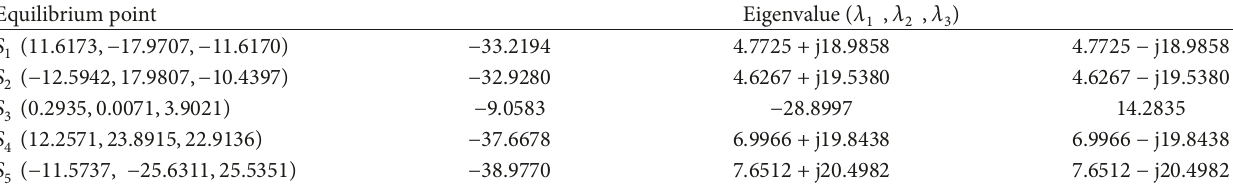
Table 1: Equilibrium points and corresponding eigenvalues of system